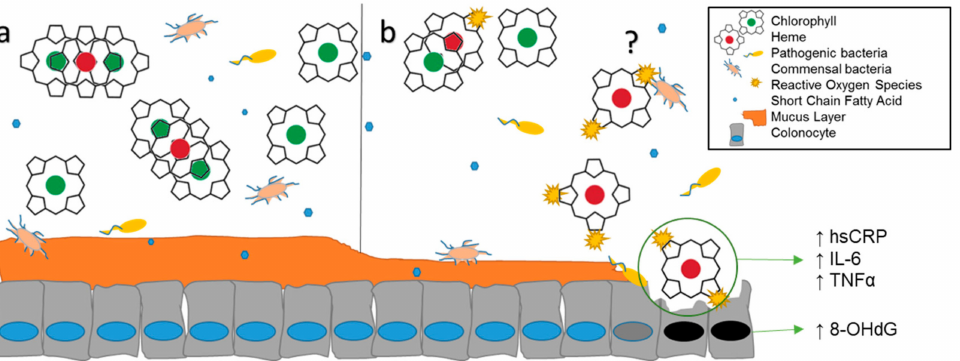
Figure 1. Anticipated e ff ects of high vs. low green leafy vegetable consumption in the colon. ( a ) In the lumen, chlorophyll binds heme, preventing cytotoxicity. ( b ) Heme is easily oxidized in the absence of chlorophyll; it is unknown if microbes, their metabolites, or both react with heme. Degradation of the mucin layer increases the susceptibility of epithelial cells to pathogens and oxidative stress, resulting in elevated systemic inflammation. Necrosis leads to compensatory hyperproliferation and DNA